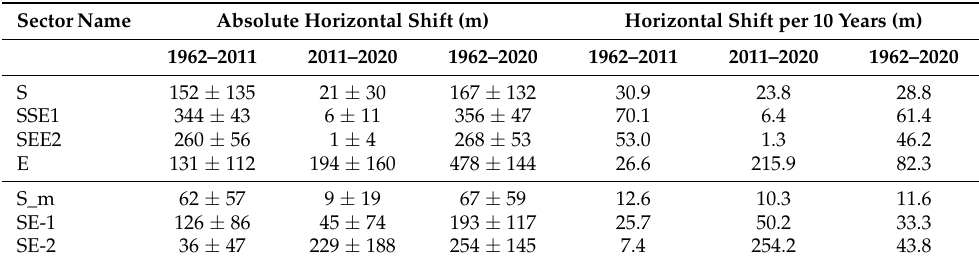
Table 4. Horizontal shifts (m) in open forest borders (mean ± SD) on the southern and eastern slopes of a hill with height mark of 312 m a.s.l., close to Mt. Chernaya (Polar Urals), in